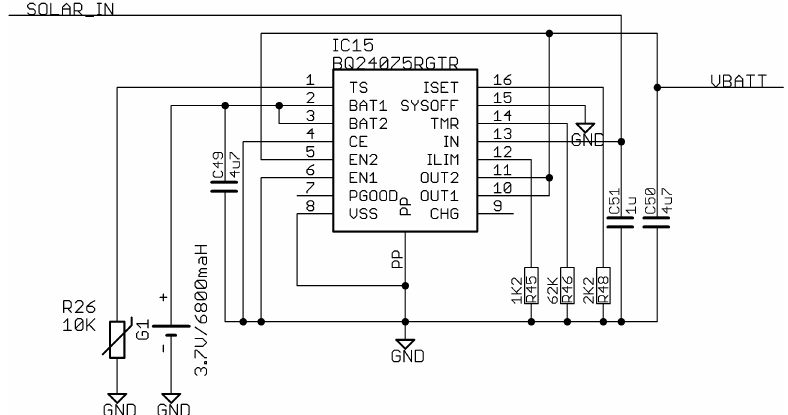
Figure A9. The schematic diagram of the charging circuit. It is based on Texas Instruments' BQ24075 integrated circuit. It accepts input from the photovoltaic via DC/DC converter so that it does not exceed 5V. It has a connection input for the battery, and the output (VBATT) provides power to the system when there is a charge on the battery and/or when there is sunshine.